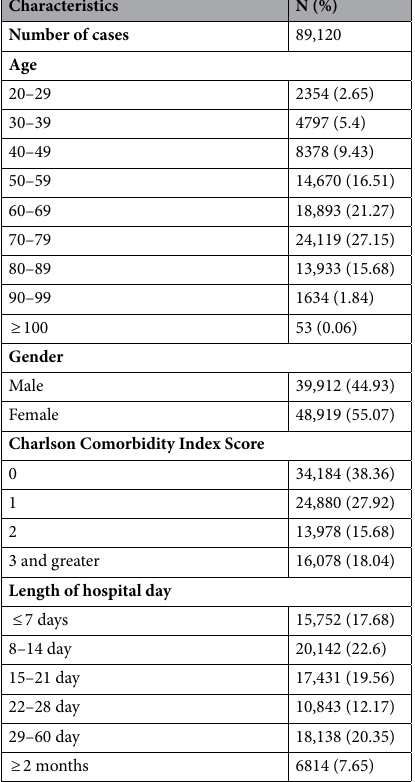
Table 2. Characteristics of the study participants.